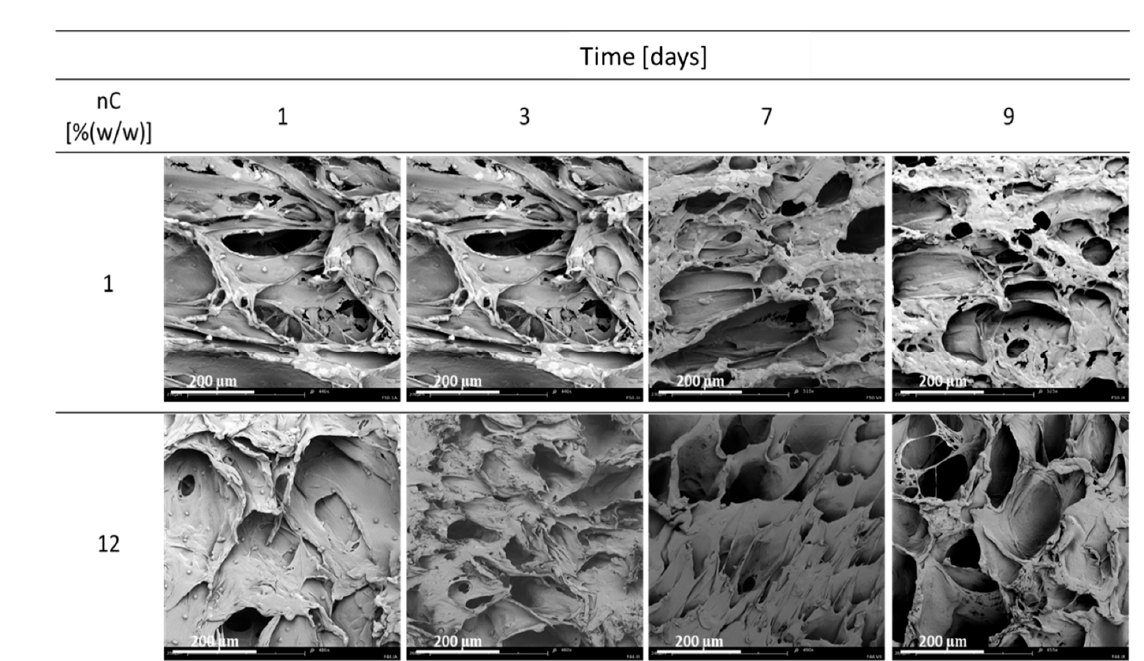
Figure 5. Cultivation of cells on composite materials containing 1 and 12% ( w/w ) nC produced at the conditions of T sat = 70 °C, P sat = 18 MPa, t sat = 1 h on days 1, 3, 7 and 9. conditions of T sat = 70 ◦ C, P sat = 18 MPa, t sat = 1 h on days 1, 3, 7 and